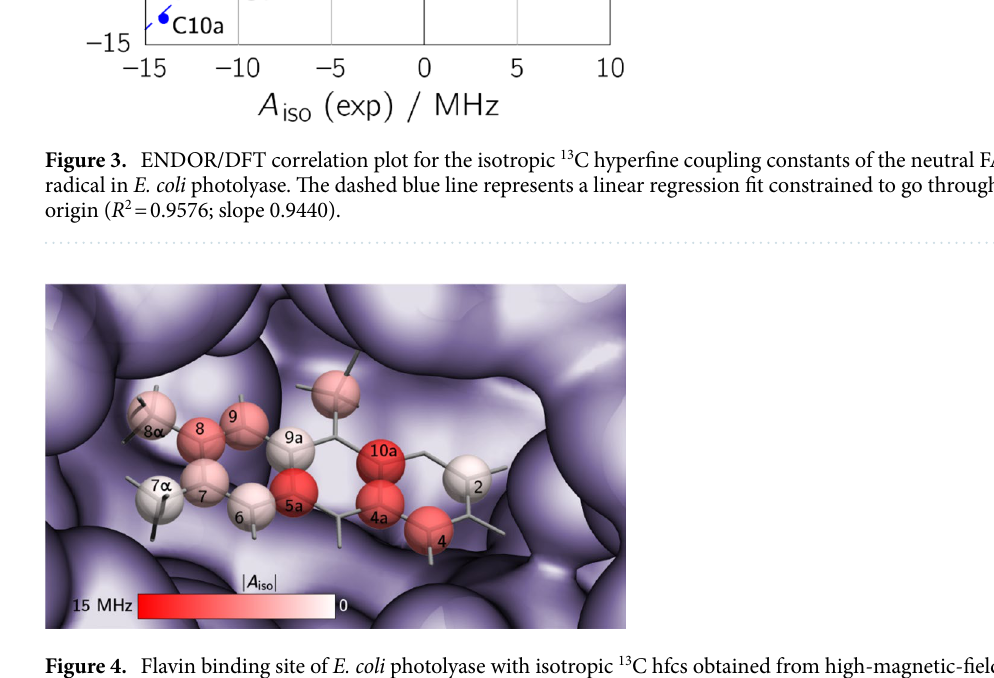
Figure 4. Flavin binding site of E. coli photolyase with isotropic 13 C hfcs obtained from high-magnetic-field ENDOR hyperfine mapping (data were taken from Table S7 in the Supplementary Information). The color intensity reflects the absolute strength of a specific coupling: bright red and white colors depict strong and very weak hfc, respectively. For further details, see experimental section. Protein and cofactor geometries were taken from the PDB: